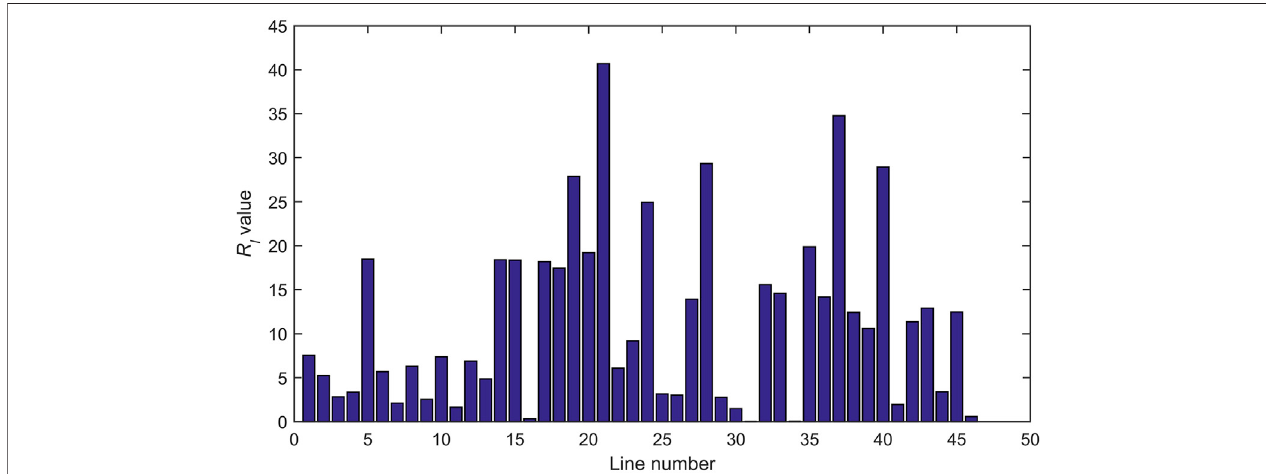
FIGURE 3 | R l value of the IEEE-39 bus power